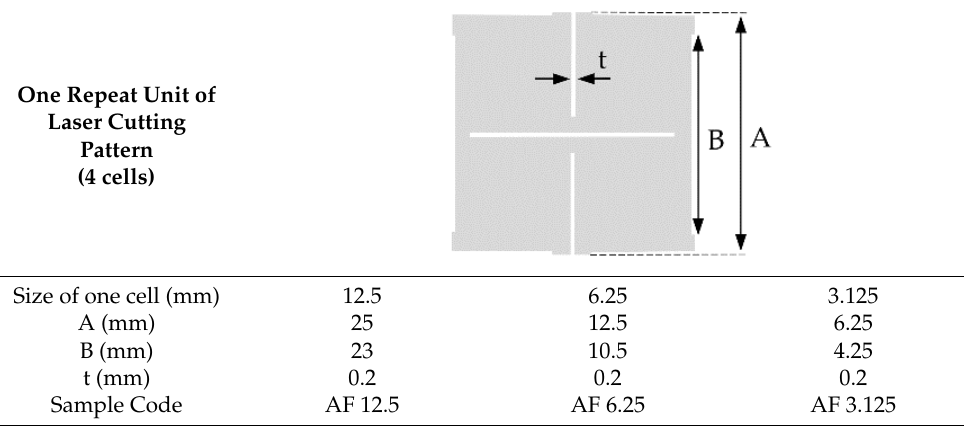
One Repeat Unit of One Repeat Unit